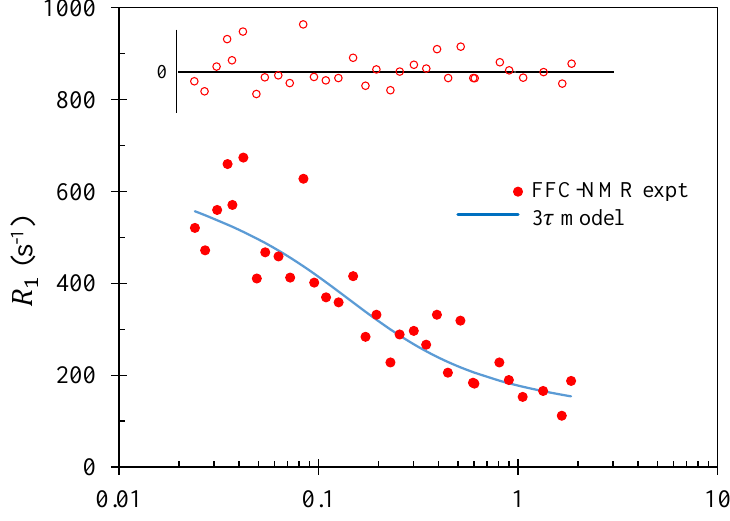
Figure 3. Fast-field-cycling nuclear magnetic resonance (FFC-NMR) spin–lattice relaxation rate data for a hydrated mortar by Barberon et al. [10], presented as a function of frequency. The solid curve represents the best fit obtained using the 3 τ model and the 3TM fitting package. The open circles represent the residuals with the horizontal line indicating a residual of